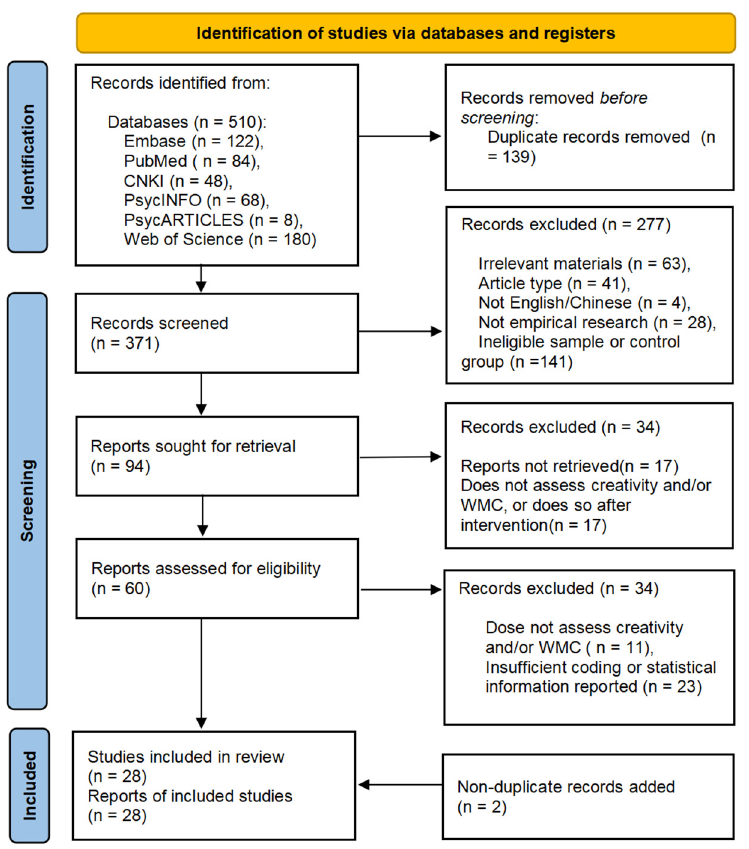
Figure 1. Flow diagram of study selection process based on the 2020 PRISMA protocol.